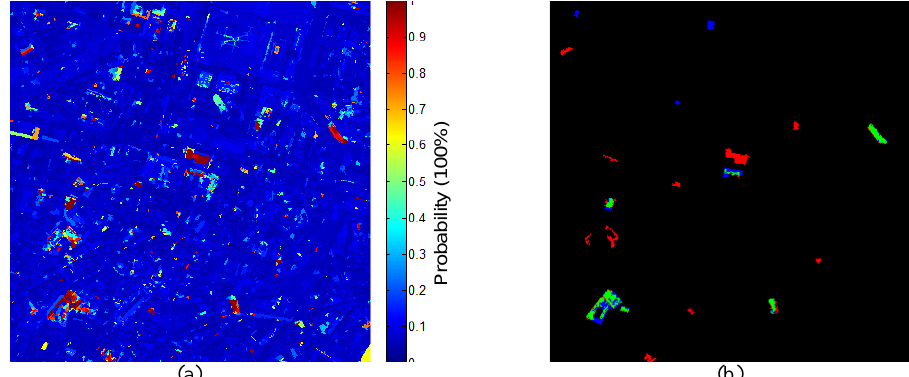
Figure 5. Change map (a) and change mask (b) generated in the Munich test area with Method I.